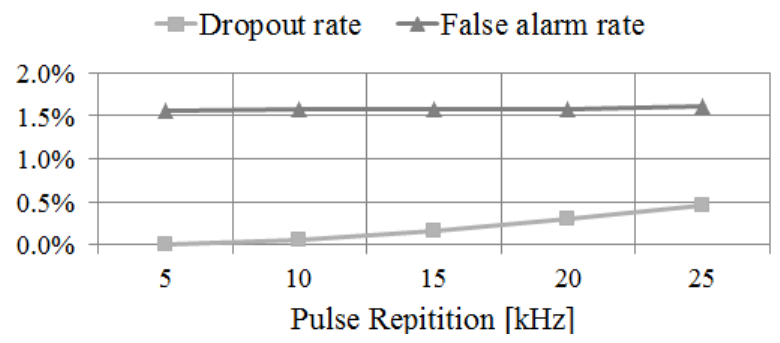
repetition rate.